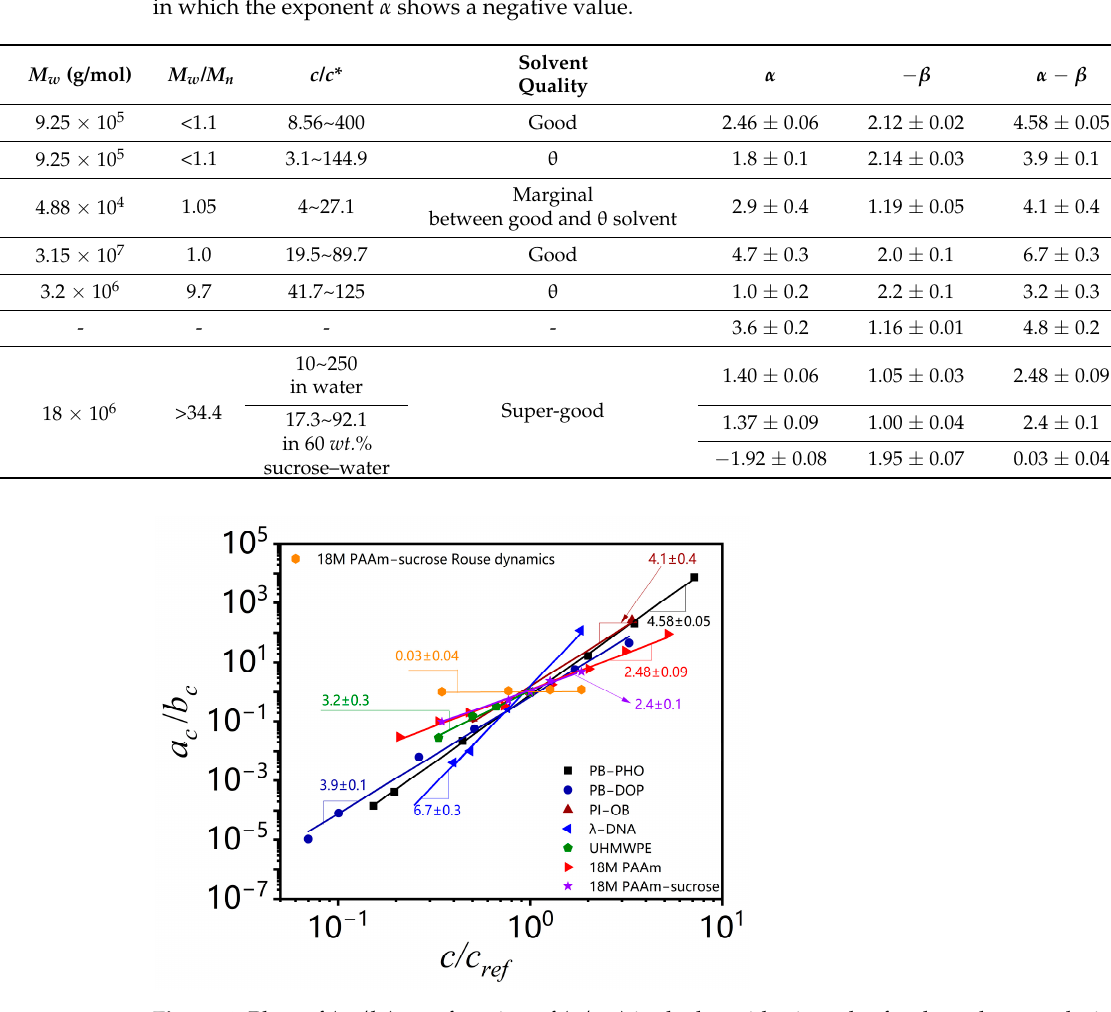
Table 1. The concentration scaling exponents α , − β and ( α − β ) of the shifting factors a c , 1/ b c and a c / b c , respectively, are estimated by TCS for a range of polymer solutions. PB–PHO and PB–DOP are monodisperse polybutadiene (PB) in phenyloctane (PHO) and in dioctyl phthalate (DOP) [4], respectively; PI–OB is monodisperse cis- polyisoprene (PI) in oligobutadiene (OB), which is a marginal solvent between good and theta solvent [13]; λ -DNA is completely monodisperse ultrahigh molecular weight linear lambda ( λ ) DNA in Tris-EDTA buffer [9]; UHMWPE is ultrahigh molecular weight polyethylene dissolved in oligo-ethylene [12]; Welan gum solutions but no information on molecular characterization available [10]; 18M PAAm is highly polydisperse 18M PAAm in aqueous binary solution [11] and in 60 wt.% sucrose–water ternary solution, respectively. The 18M PAAm ternary solution was analyzed with respect to the terminal entanglement dynamics as well as Rouse dynamics in which the exponent α shows a negative value.